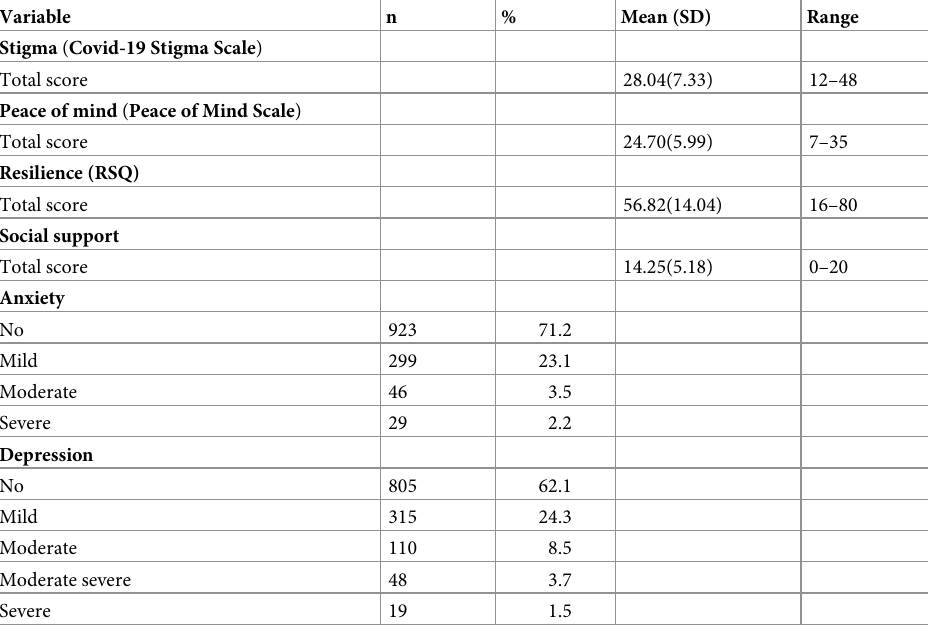
Table 2. Mental health status of enrolled COVID-19 survivors.